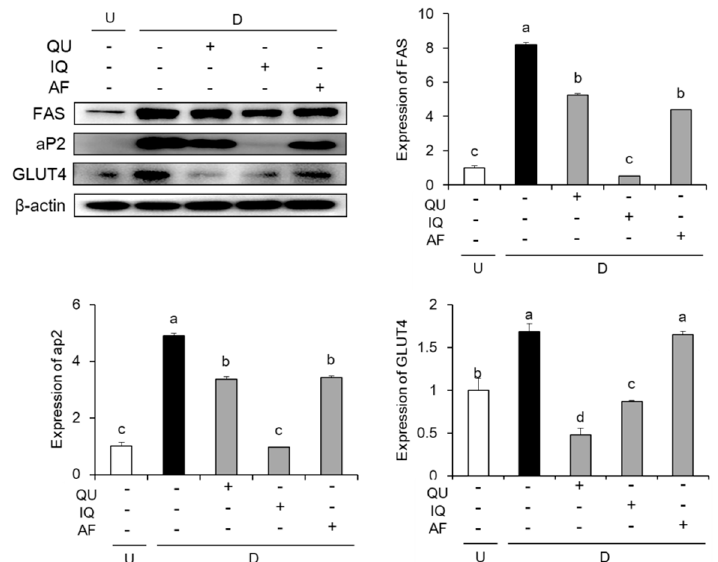
Figure 5. Effects of flavonoids from Acer okamotoanum (10 µg/mL) on lipogenesis-related protein expressions in differentiated 3T3-L1 cells. Adipocyte differentiation was induced by treatment with MDI media in the absence or presence of flavonoids from A. okamotoanum during 2 days. The MDI media was then replaced with insulin media, and it was changed four times for every 2 days. Data are expressed as the mean ± standard deviation. a–d Means with different letters indicate significant differences ( P < 0.05) by Duncan’s multiple range test. β -actin was used as a loading control. Relative expression levels were normalized to the β -actin levels and the normal group. Normal group indicates non-differentiated cells, whereas control group indicates the differentiated cells by treatment of MDI media. U: Undifferentiation; D: Differentiation; QU: Quercitrin; IQ: Isoquercitrin; AF: Afzelin.